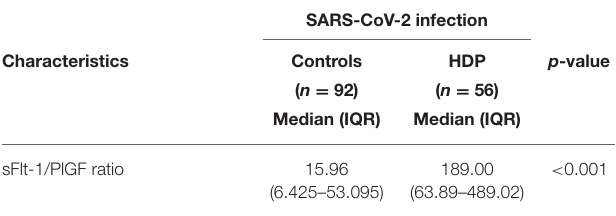
TABLE 2 | Maternal, fetal, and neonate outcomes for SARS-CoV-2 participants.